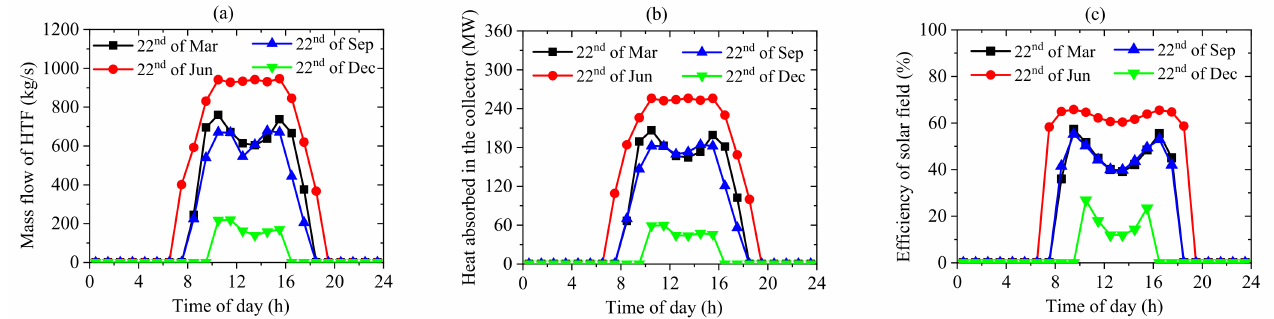
Figure 14. Daily variations of the operating performance of the SF under four different reference days: ( a ) mass flow rate of HTF; ( b ) heat amount absorbed in the solar field; ( c ) thermal efficiency of the solar